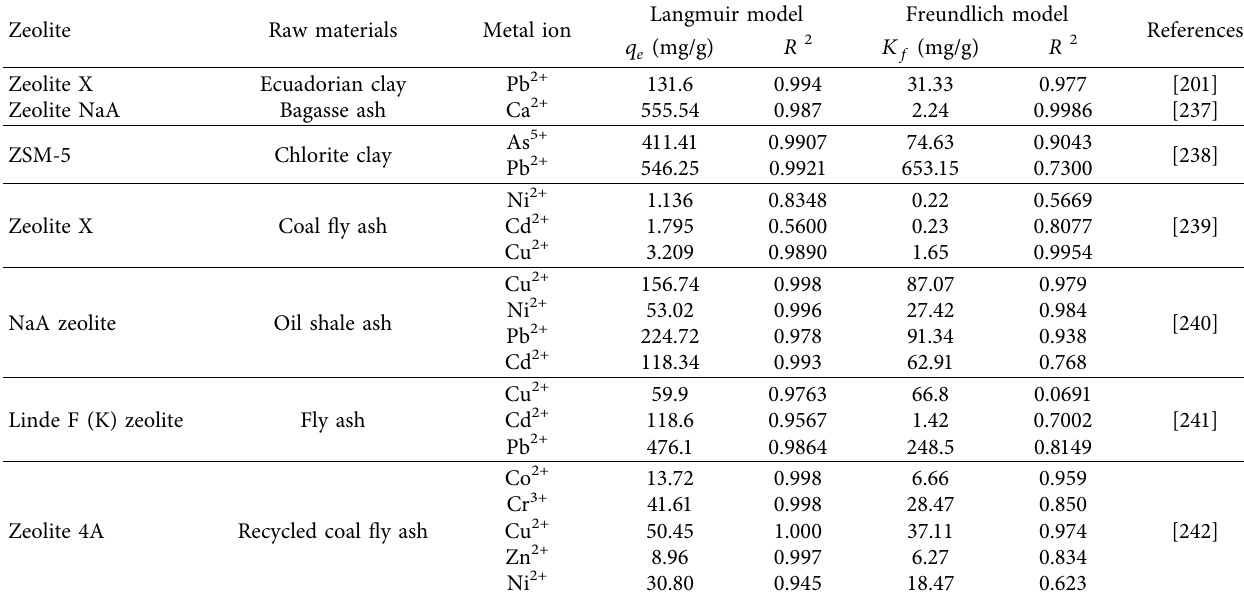
Table 9: Summary of adsorption isotherms on synthetic zeolites derived from agro-wastes and clay.